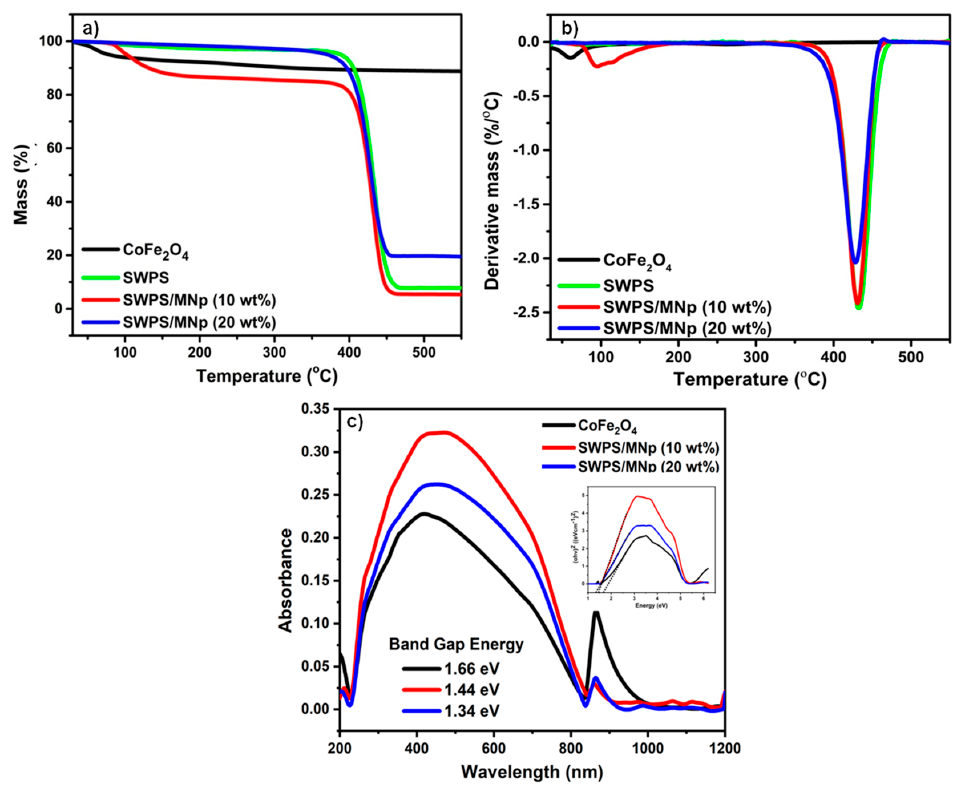
Figure 4. (a ) TGA curves; ( b ) DTG curves and ( c ) solid UV spectrum (inset shows Tauc plot). Figure 4. ( a ) TGA curves; ( b ) DTG curves and ( c ) solid UV spectrum (inset shows Tauc